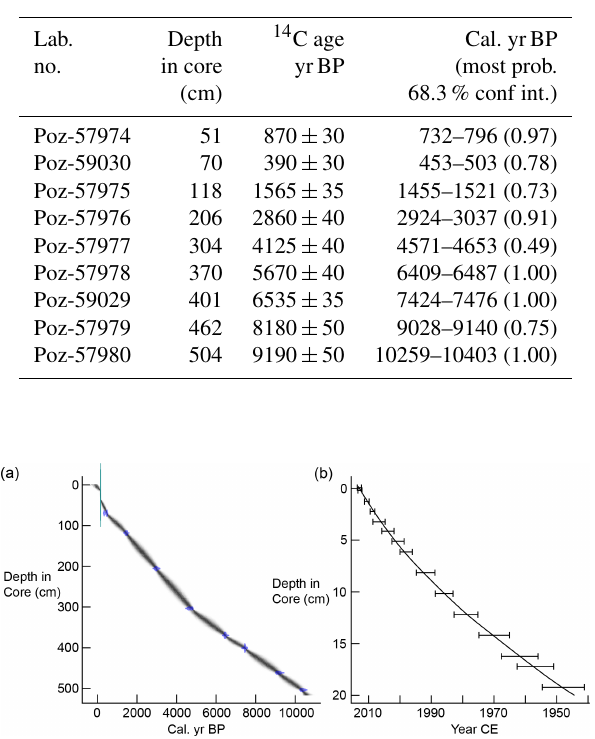
Figure 11. Age–depth model for FLP213 (b) and FLS113 (a) . Note the step in the FLP213 age–depth model at 33.5–18.0cm depth in the core related to the Stor-Ofsen flood event in